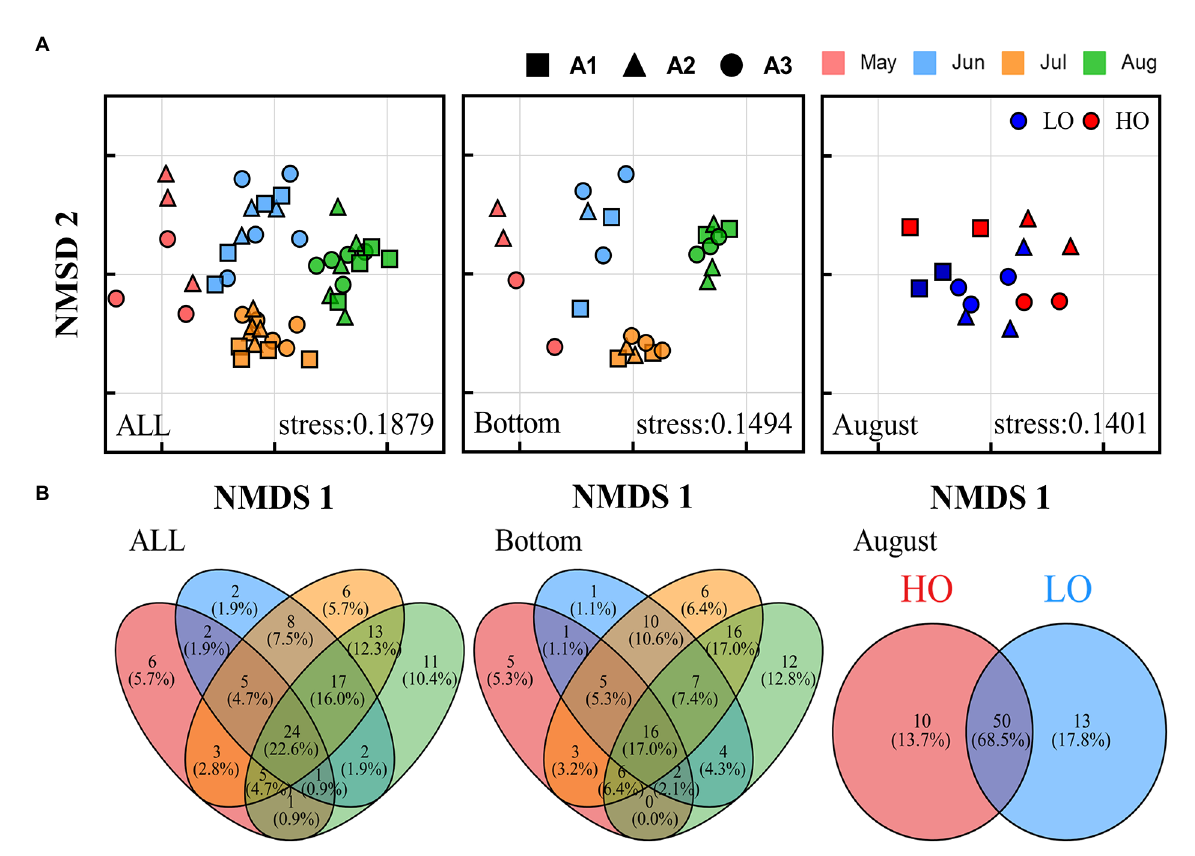
FIGURE 4 Community structure of pathogenic bacteria in the Bohai Sea over 4 months. (A) Non-metric multidimensional scale (NMDS) analysis of different microbial communities. (B) Venn diagram showing the number of unique and shared OTUs between different months for different